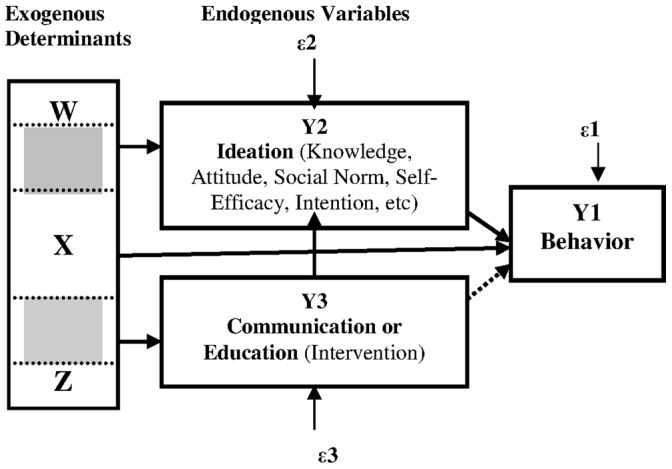
A Model of Behavior Change Communication.